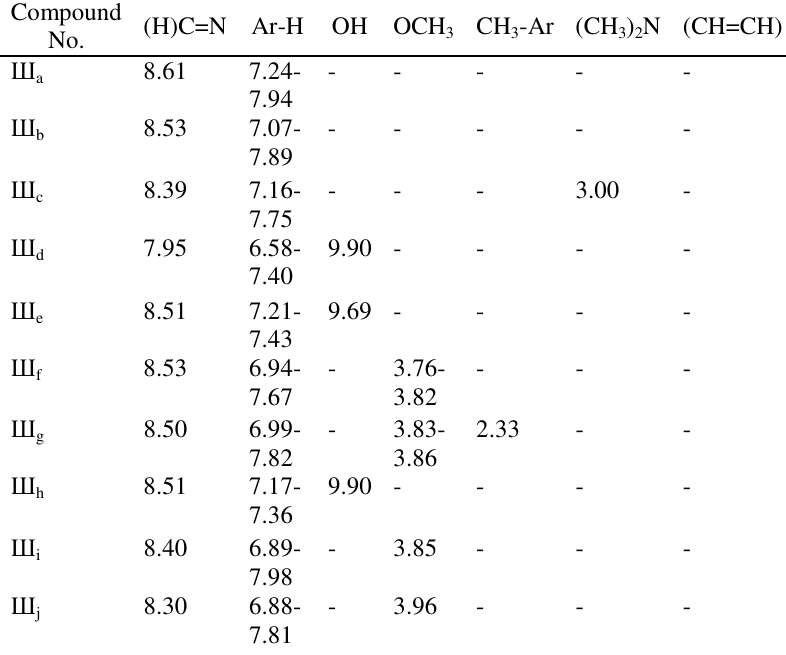
1 H-NMR Data of Schiff bases ( (cid:1) in ppm)